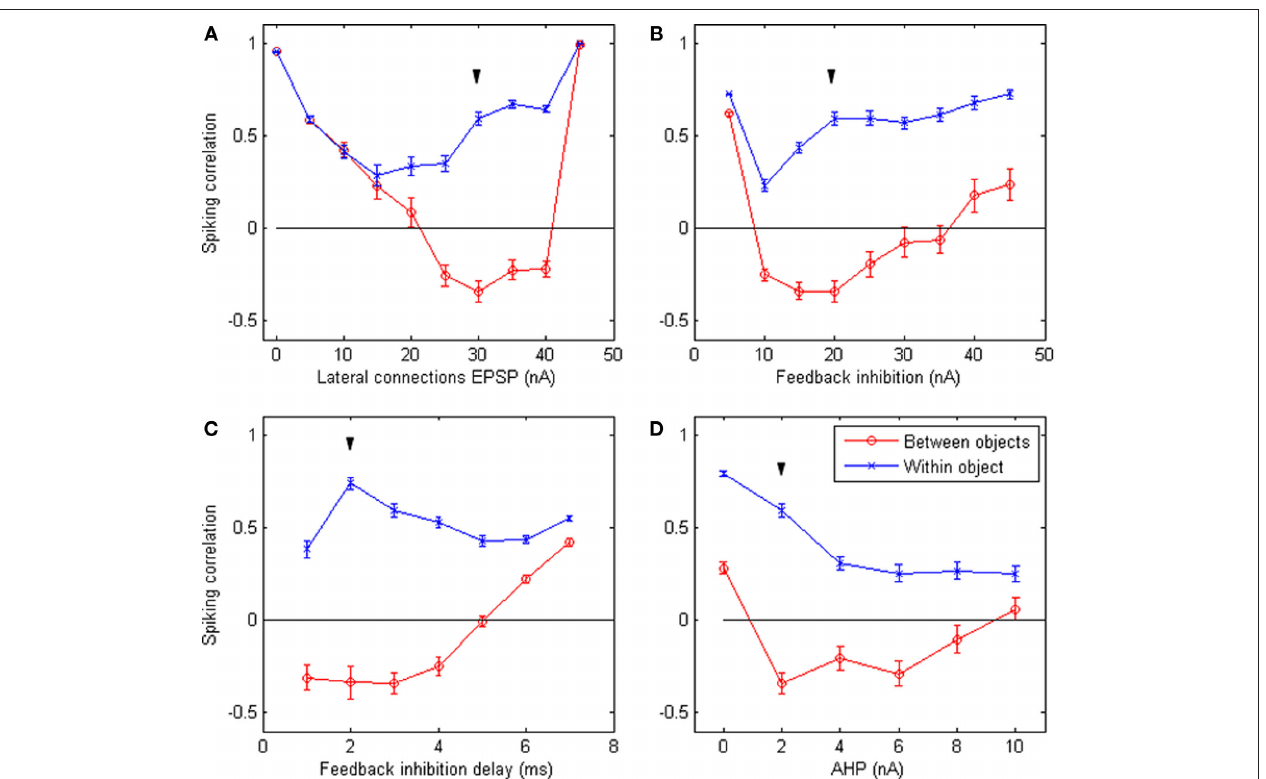
runs; error bars indicate s.e.m. Down arrow (  ) indicates default value. The expected behavior (positive within-object correlation, negative between- objects correlation) emerges over a wide range of parameters. Significant differences between within-object and between-objects correlations occur for an even wider range of parameters. However the behavior breaks down in the absence of lateral connections (top left) or feedback inhibition (top right), confirming that these are the crucial requirements for the emergence of perceptual